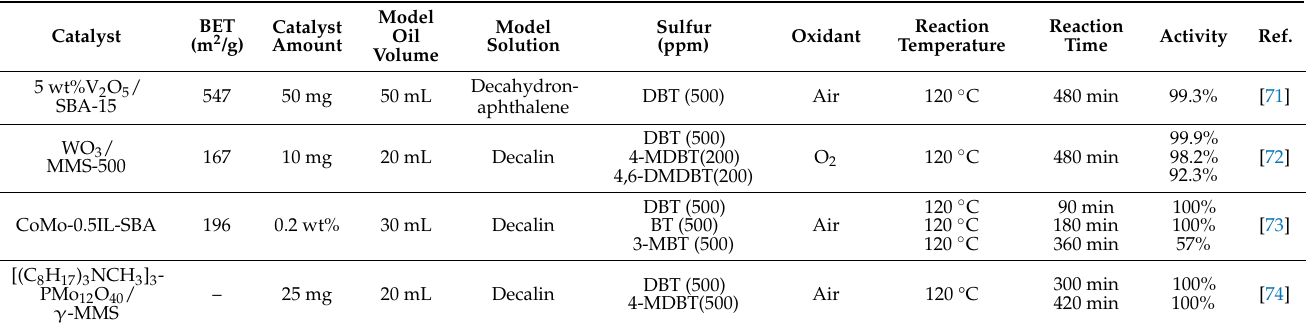
Table 3. Comparison on the AODS catalytic performance of mesoporous silica/metal oxides composites.